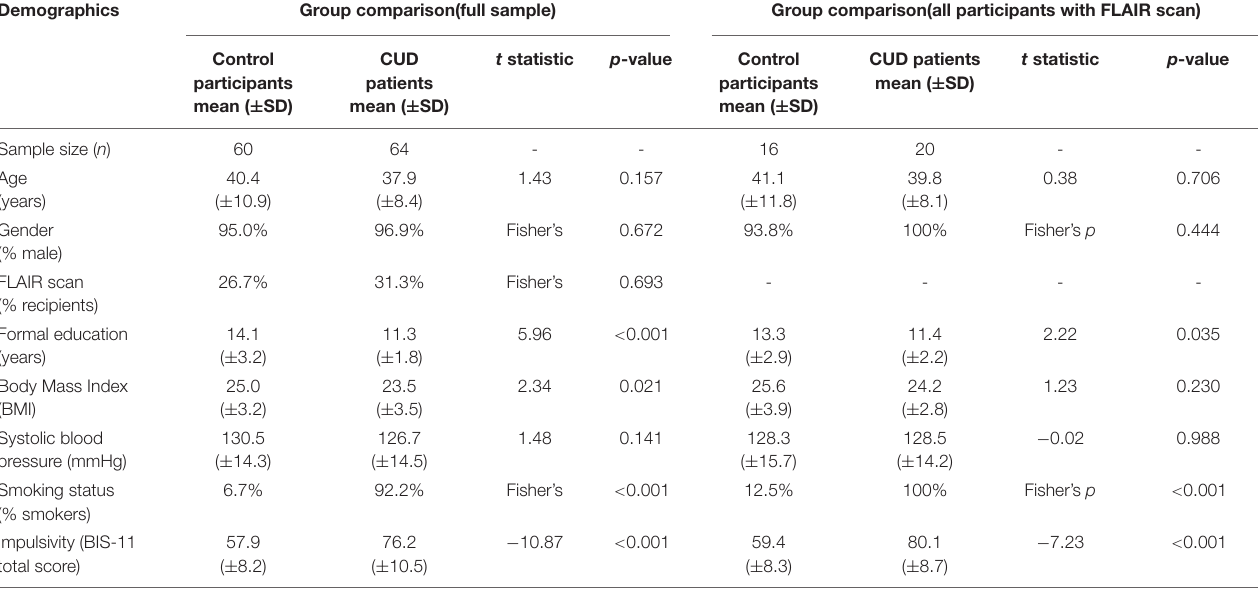
TABLE 1 | Demographics, personality traits, and clinical data [means and standard deviation (Std.) in parentheses] of the full sample and the subgroups that received a FLAIR scan. Demographics Group comparison(full